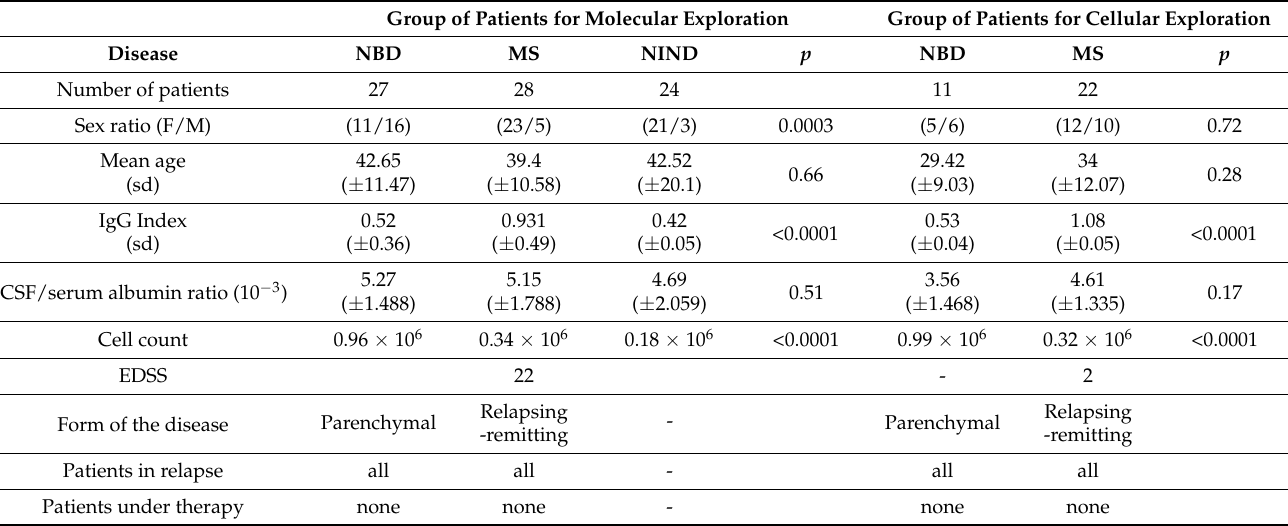
Table 1. Demographic, biological and clinical characteristics of